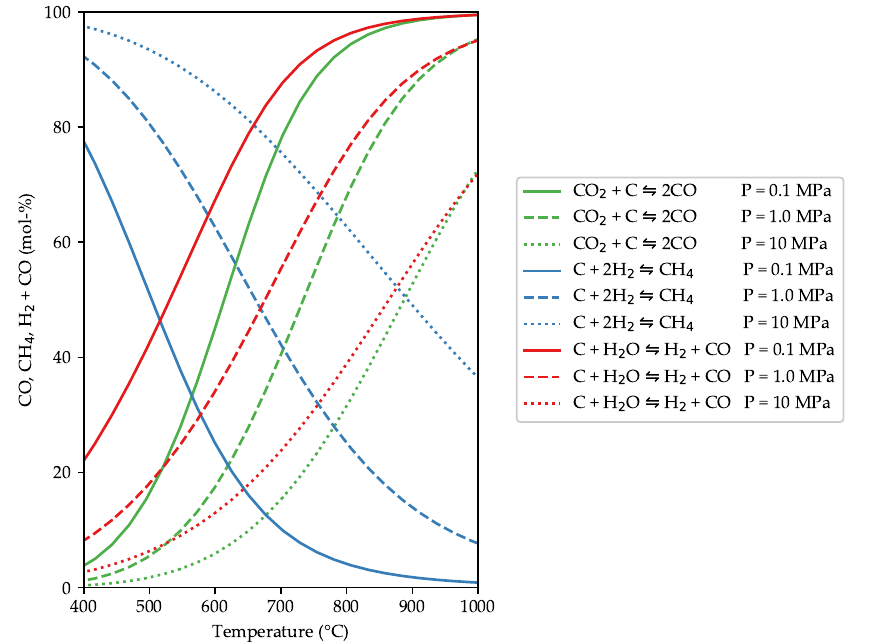
Figure 1. Equilibrium states of the Boudouard (green), methanation (blue) and water-gas reactions (red) at varying temperatures and pressures simulated with the Cantera software package